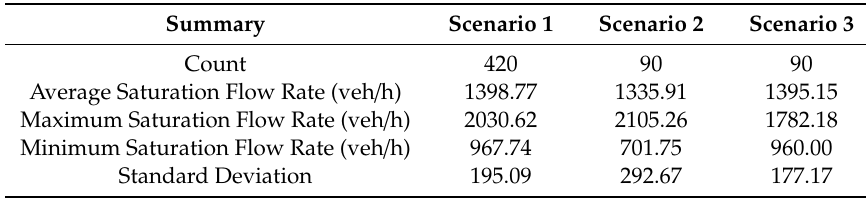
Table 3. Descriptive statistics of field saturation flow